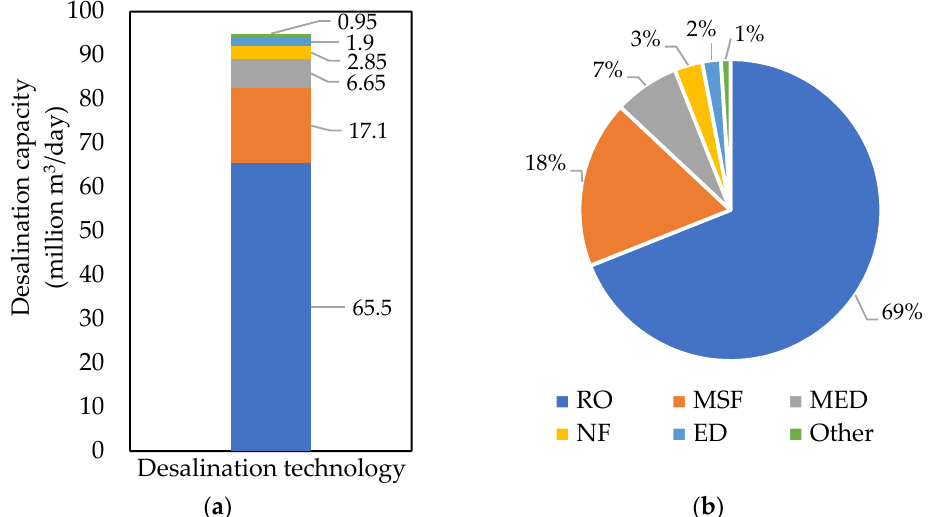
Figure 4. Desalination technology distribution in 2019: ( a ) desalination capacity (million m 3 /day); ( b ) desalination capacity (%), data from [37].